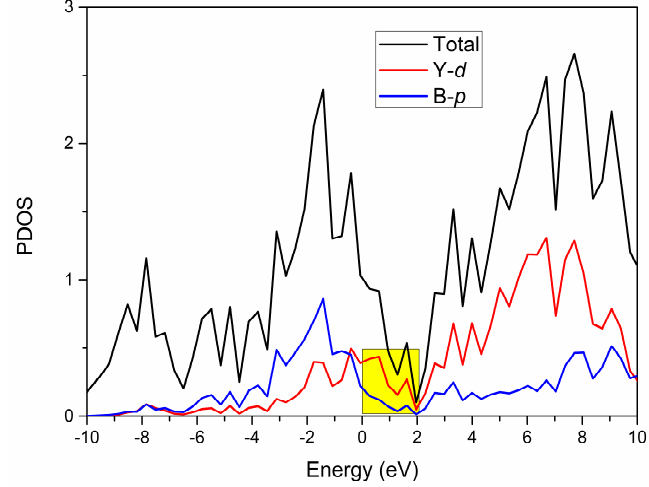
Figure 3. The total and projected density of states (PDOSs) of YB 2 without considering the spin–orbit coupling effect. The Fermi level energy is set at zero.